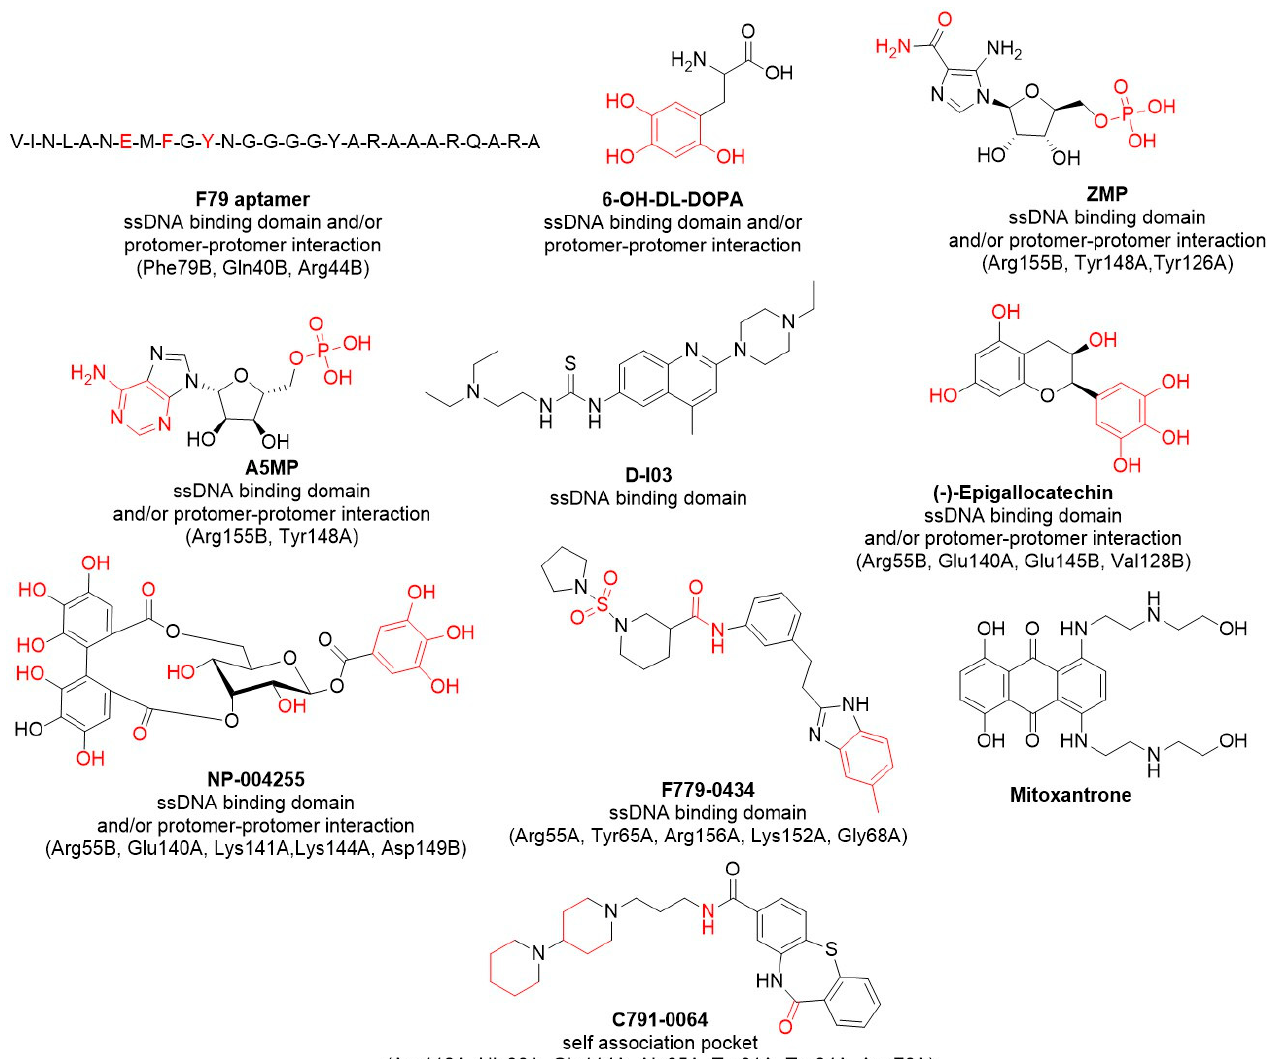
Figure 10. Structures of most recent and relevant inhibitors targeting RAD52. Inhibitors names are in bold, with their binding pockets with the amino acids of interest in brackets; A or B following the amino acid numbers indicates if the amino acid belongs to RAD52 protomer A or B; functional groups that establish specific interactions with amino acids are reported in red; Phe-Phenylalanine; Gln-Glutamine; Arg-Arginine; Tyr-Tyrosine; Glu-Glutamate; Val-Valine; Asp-Aspartate; Lys-Lysine; Gly-Glycine; Asn-Asparagine; Trp-Tryptophan; His-Histidine; Ala-Alanine;.